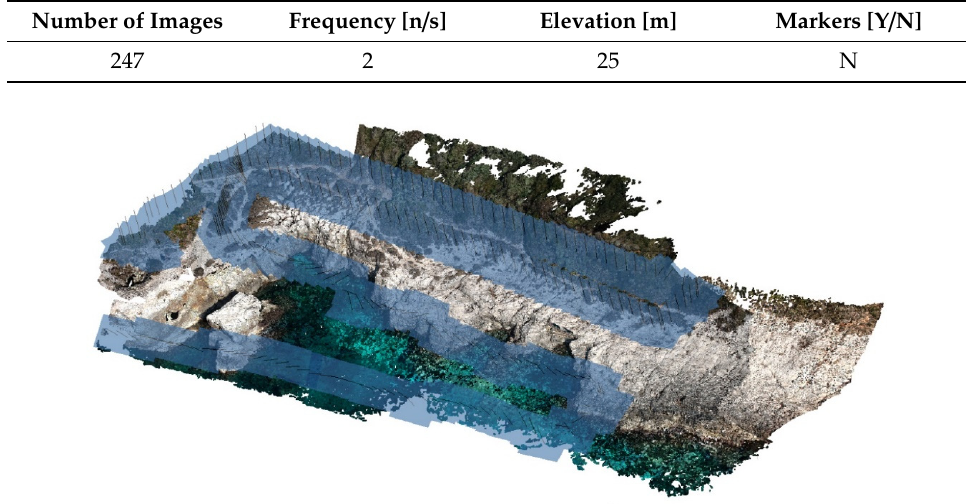
Figure 9. Dense cloud and acquisition points with drone at site 2.